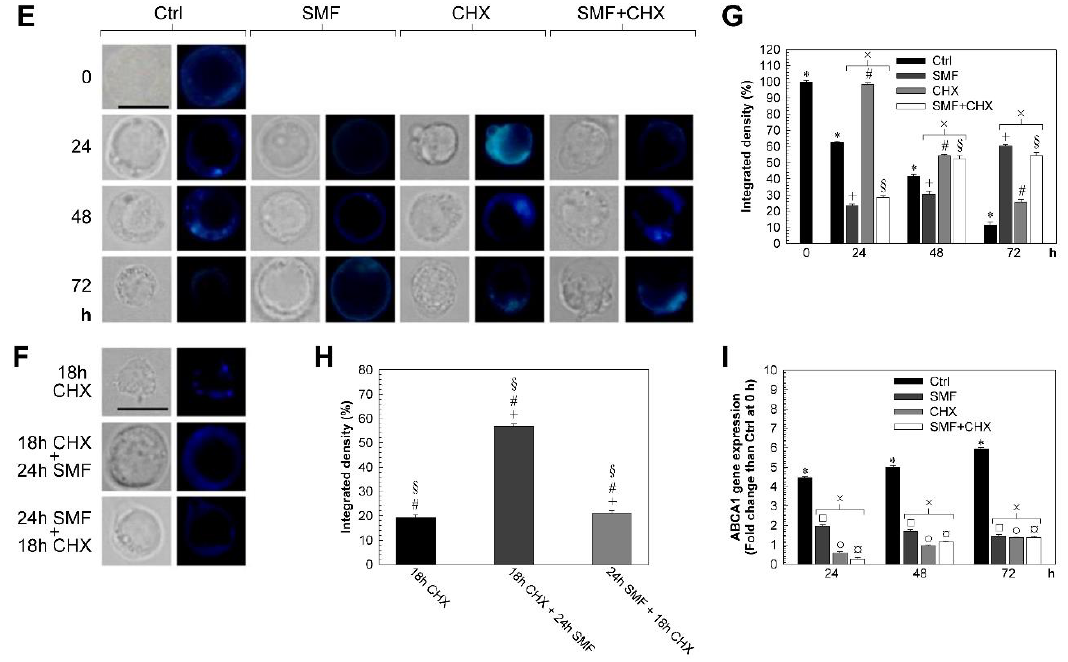
Figure 2. Fluorescence staining of GD3 and cholesterol and ABCA1 gene expression. ( A – B , E – F ): LM micrographs of PBLs following different treatments and labeled with anti-GD3 (A–B, GD3, green) or filipin (E–F, cholesterol, blue), taken with a fluorescence LM Eclipse 80i equipped with an illuminator Hg-C HGFIE of 130 W and DXM 1200F digital camera (Nikon), by setting a bright-field or a green (A–B, GD3) / blue (E–F, cholesterol) filter. ( C – D , G – H ): Density integrated in the green (C–D, GD3) / blue (G–I, cholesterol) channel fluorescence of LM micrographs quantified by using the image software ImageJ (US NIH) (left). In each experiment, at least 500 cells were scored. ( I ): ABCA1 gene expression levels (RT-qPCR) of PBLs following different treatments than control at the baseline time-point (0 h), by considering the 18S rRNA housekeeping gene as an internal control. The error bar represents the SE of five independent experiments, each performed in duplicate. All values plotted relate to the value of control PBLs at time 0 h (T0), taken as 100%. × indicates a significant value than control ( p < 0.05), whereas □, ○ , ¤ ( p < 0.0167), * ( p < 0.0083), + ( p < 0.005) and # and § ( p < 0.0033) indicate significant values compared to those indicated with the same symbol. Abbreviations: Ctrl = control PBLs, SMF = PBLs exposed to 6-mT SMF, CHX = PBLs treated with 10-mM CHX, SMF + CHX = PBLs exposed to SMF and treated simultaneously with CHX, 18-h CHX + 24-h SMF = PBLs exposed for 24 h to 6-mT SMF following treatment with CHX (10 mM) for 18 h, 24-h SMF + 18-h CHX = PBLs treated with CHX (10 mM) for 18 h following exposure for 24 h to 6-mT SMF, h = hours and bars = 10 μm.